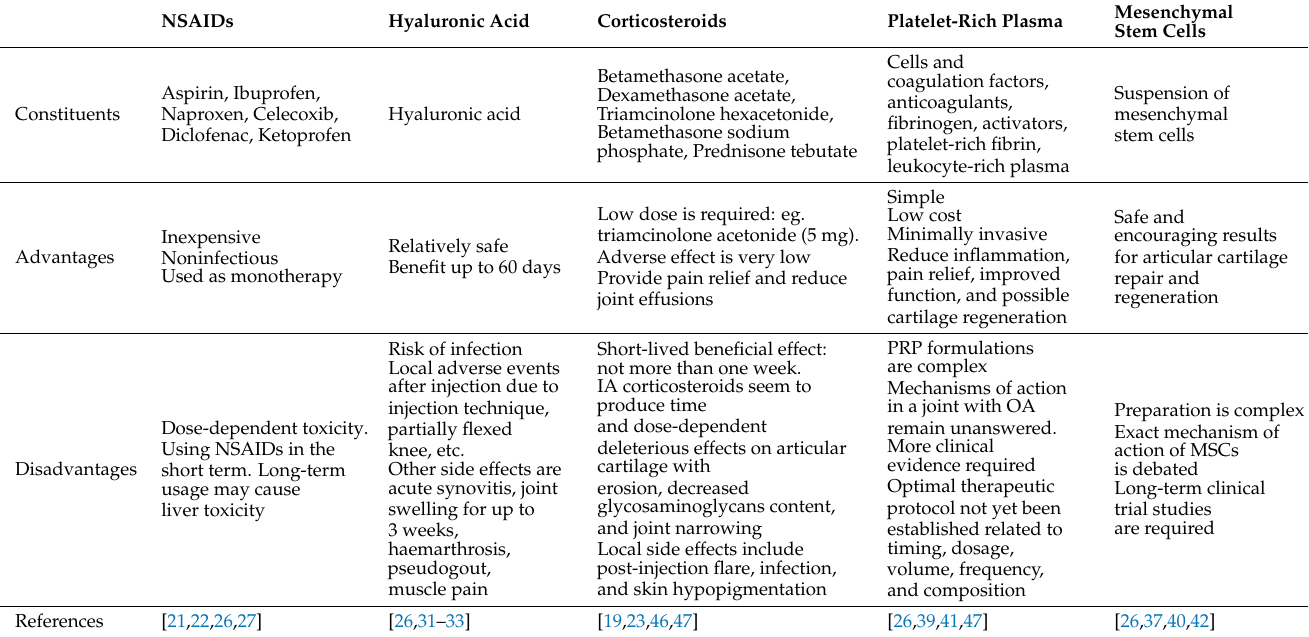
Table 1. Types of intra-articular treatments used in the management of joint